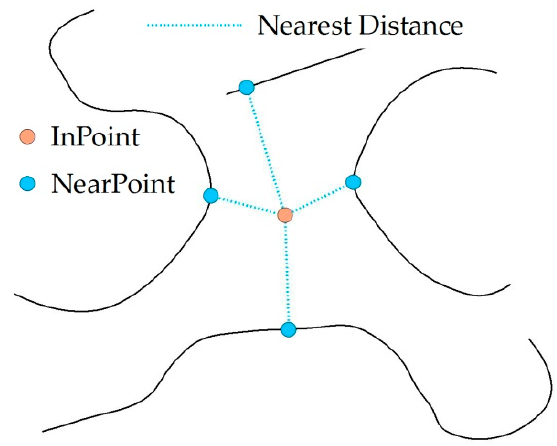
Figure 3. Relationship between InPoint, NearPoint, and Nearest Distance.